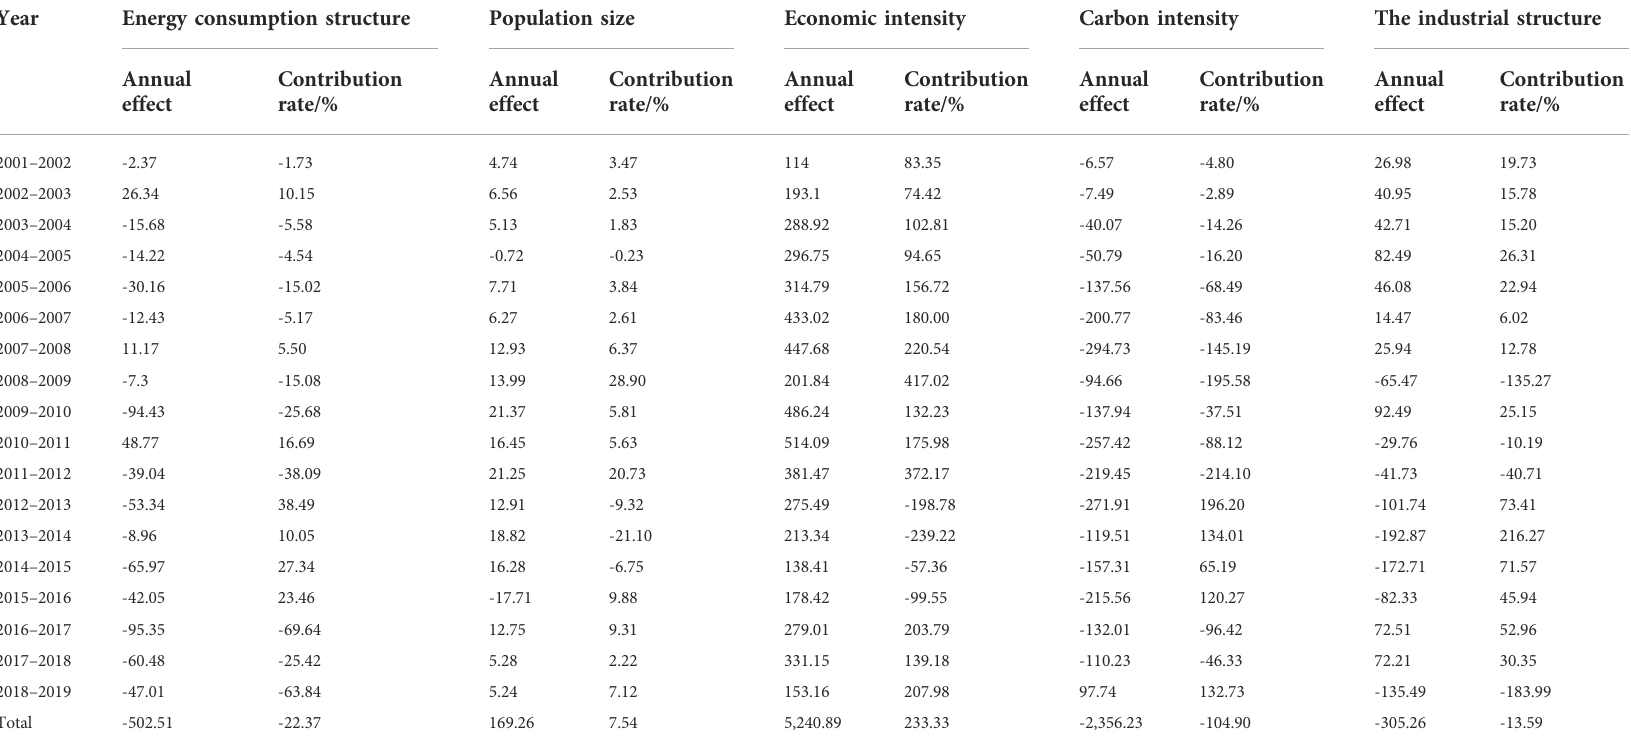
TABLE 7 Annual effects of various driving factors of carbon emissions in the YRB from 2001 to